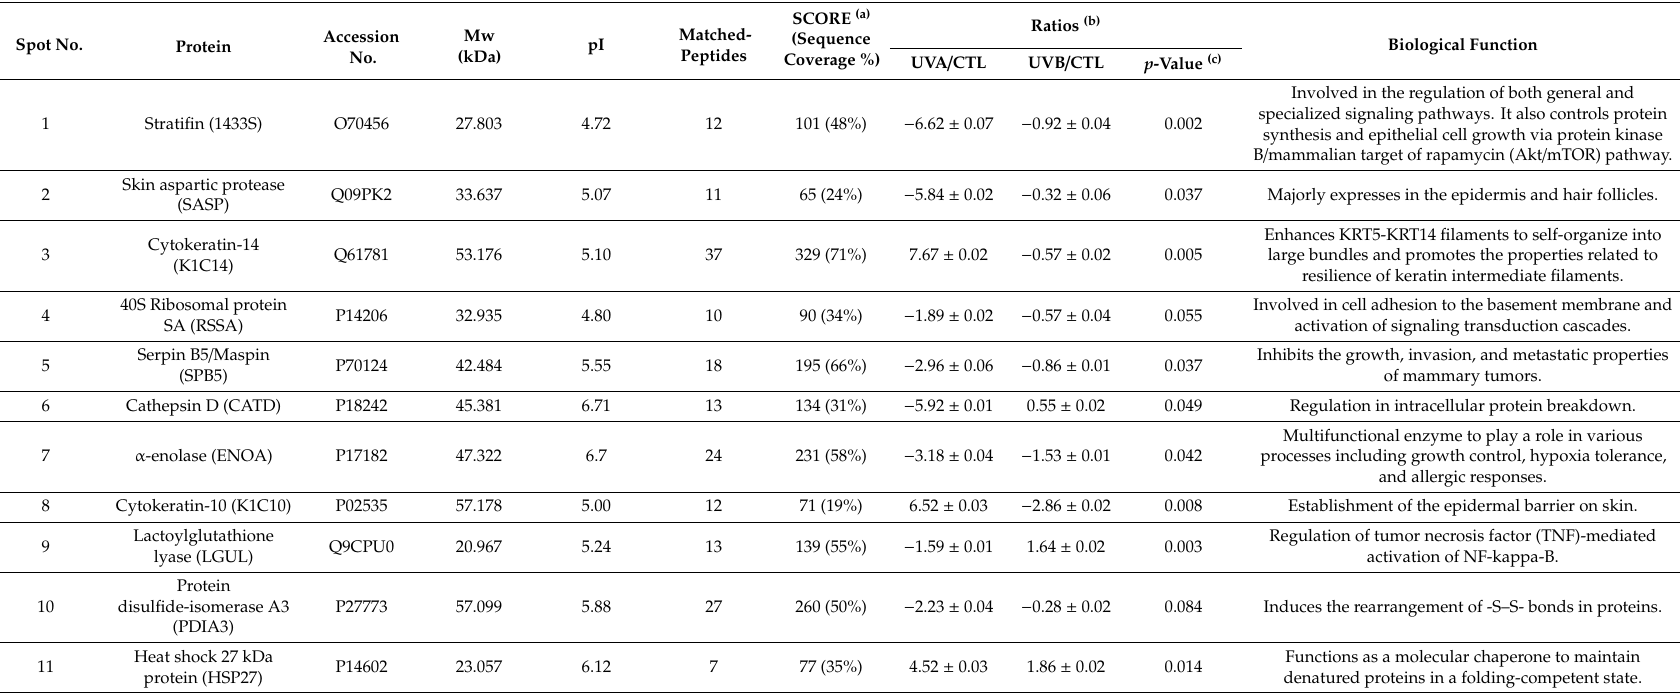
Table 1. Di ff erentially expressed proteins in the nude mice skin under UVA- and